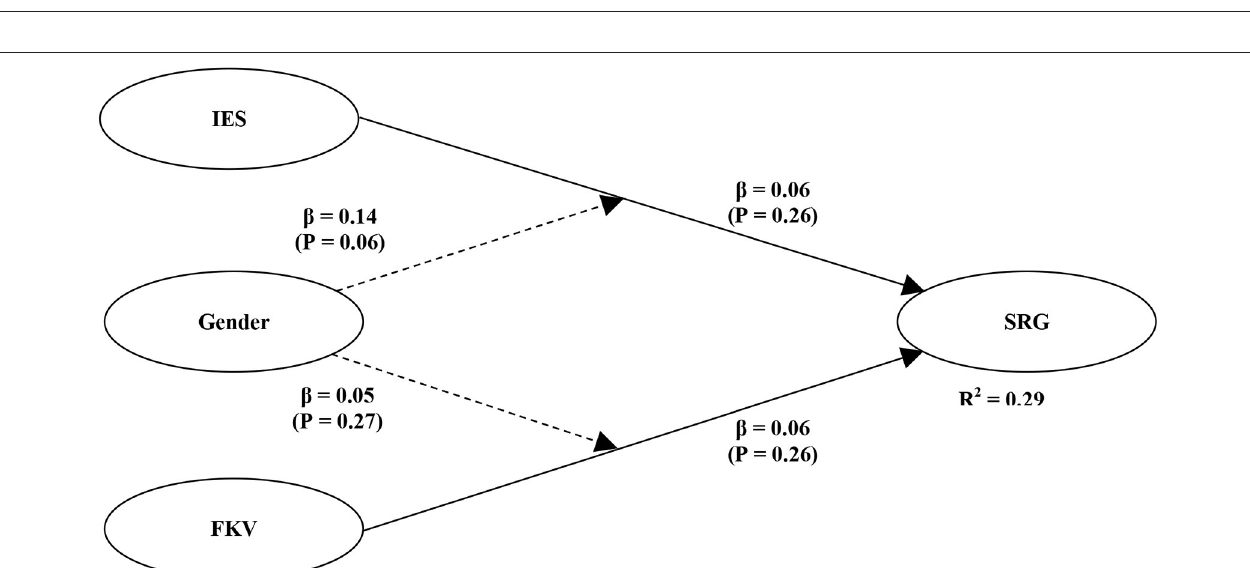
FIGURE 1 | Structural model 1.